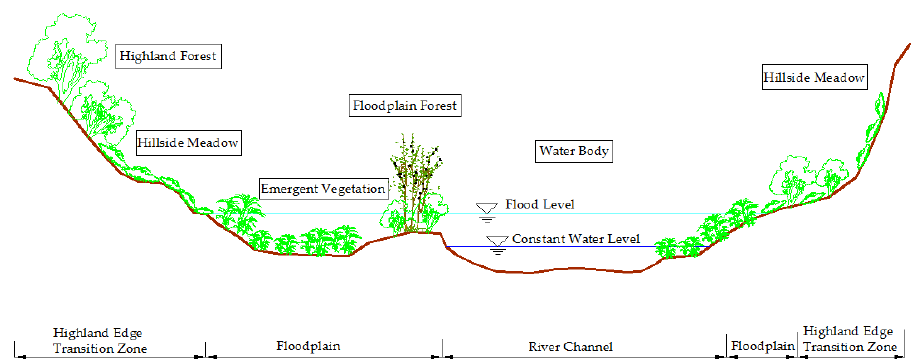
Figure 3. Cross-sectional structure diagram of the river channel. The transversal structure of river ecological corridor includes river channels, floodplain, and highland edge transition zone. The floodplain is mainly affected by the water level, which is the area of highly variable. The distribution of vegetation varies with the structure of the river ecological corridor, such as highland forest, emergent vegetation, floodplain forest, and hillside grassland.